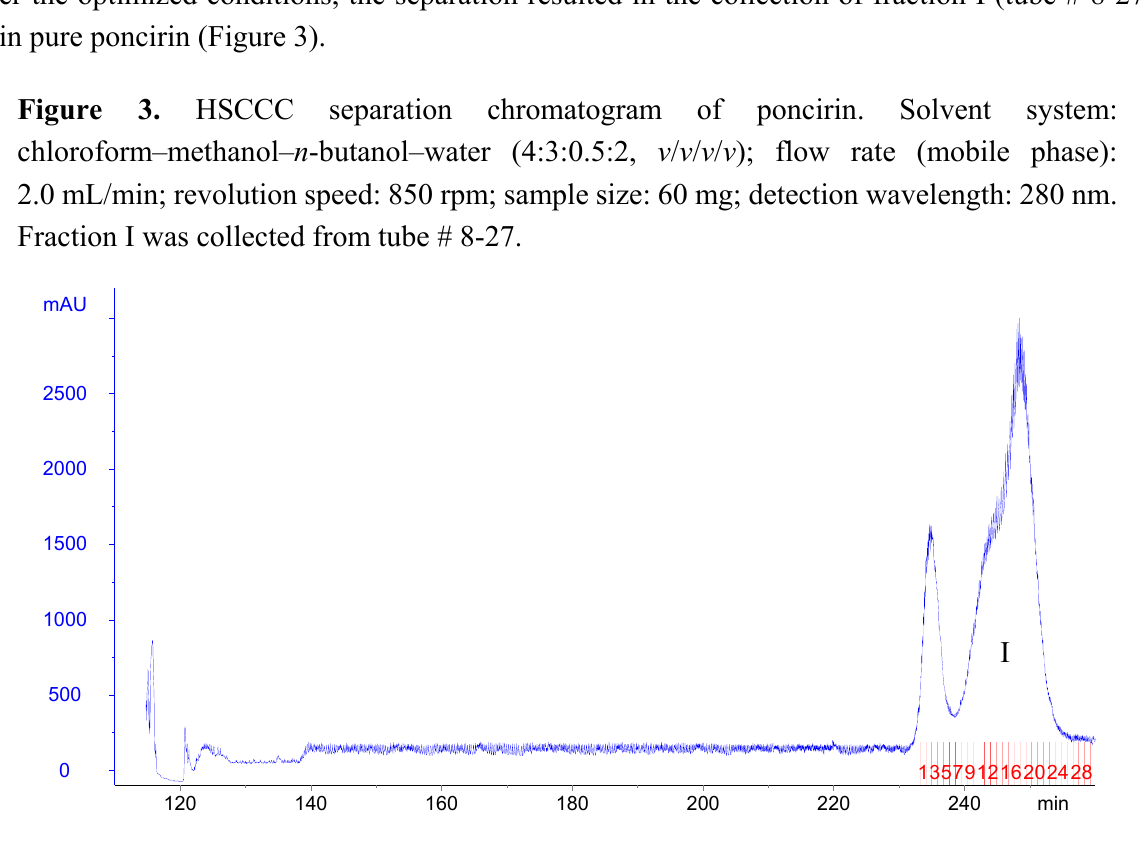
Figure 3. HSCCC separation chromatogram of poncirin. Solvent